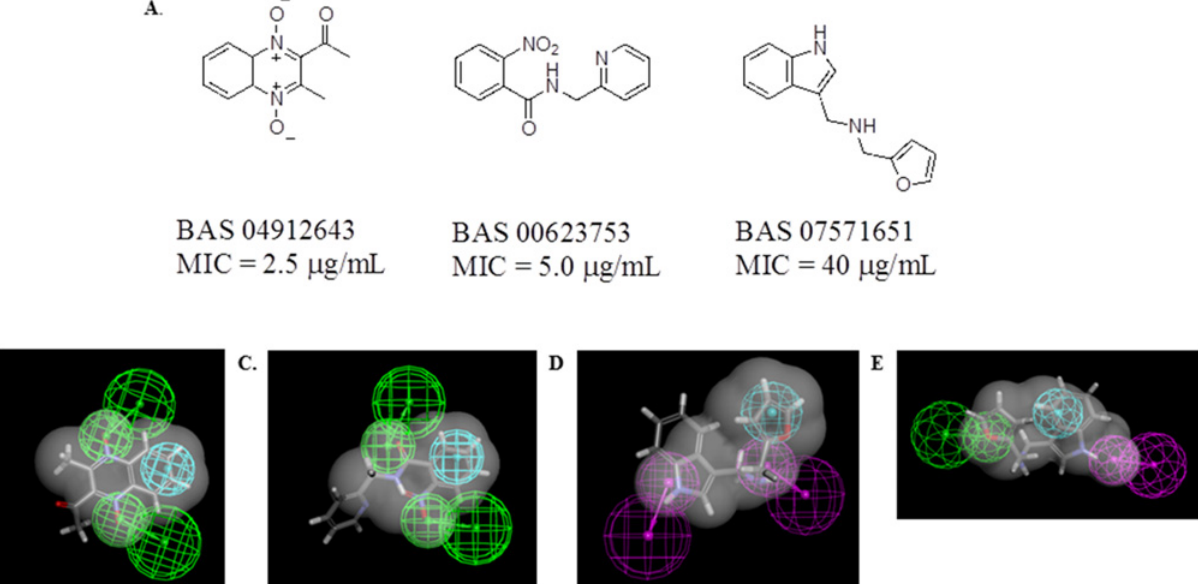
Fig 1. Initial pharmacophore/Bayesian model-derived hits: A) chemical structures, in vitro antitubercular activity, and B) best fit to menadione pharmacophore of BAS04912643, C) best fit to menadione pharmacophore of B. BAS00623753 (grey). D. best fit to indole-3-acetamide pharmacophore of BAS7571651, E best fit to lipoamide shape of BAS7571651. The pharmacophores consist of hydrogen bond acceptors (green) hydrogen bond donors (purple) and hydrophobic features (blue). The van der Waals surface was used to limit the number of compounds retrieved when screening the vendor library.